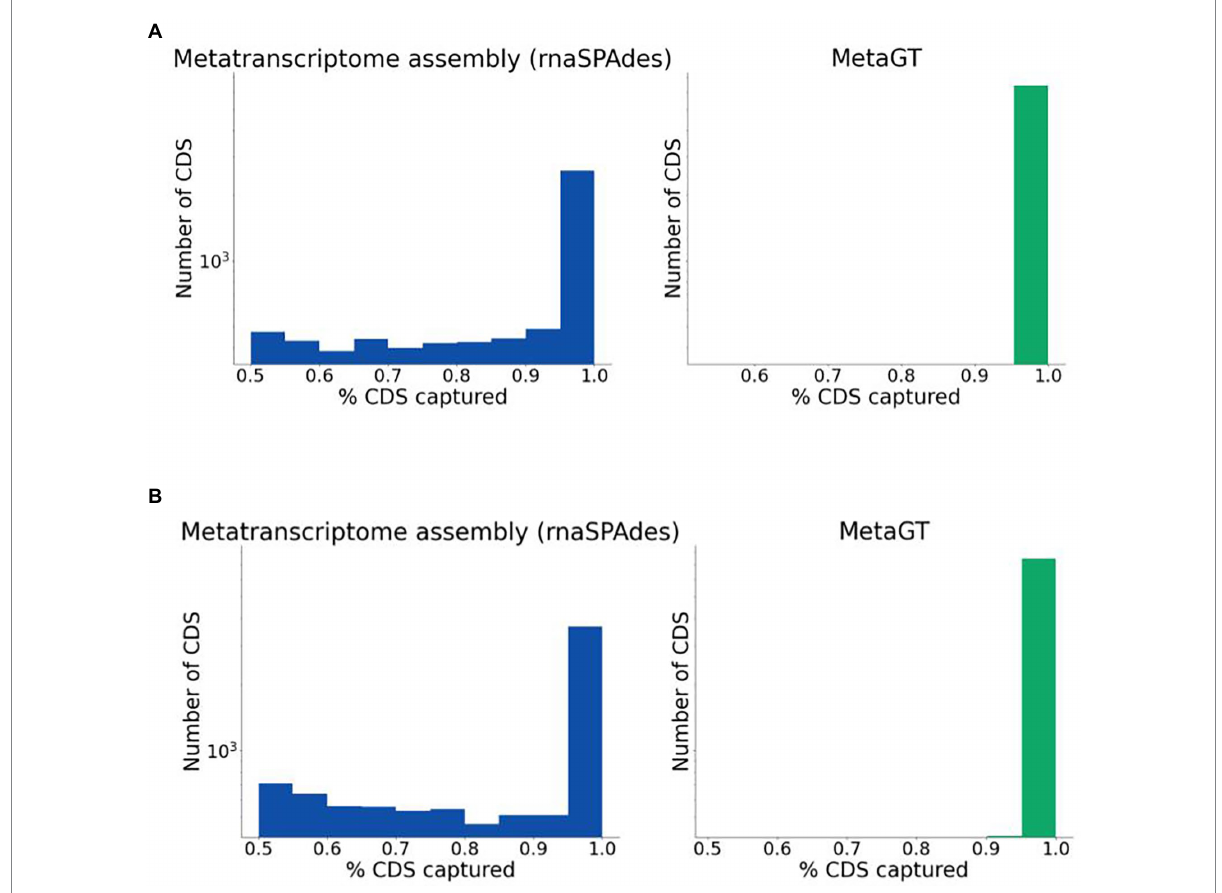
FIGURE 3 Completeness of sequences assembled from real data. (A) Histogram for percentage of coding regions captured by rnaSPAdes (left) and MetaGT (right) assemblies on the Mock16 dataset. The histogram is shown in logarithmic scale. (B) Same as (A) , but for the HumanGut